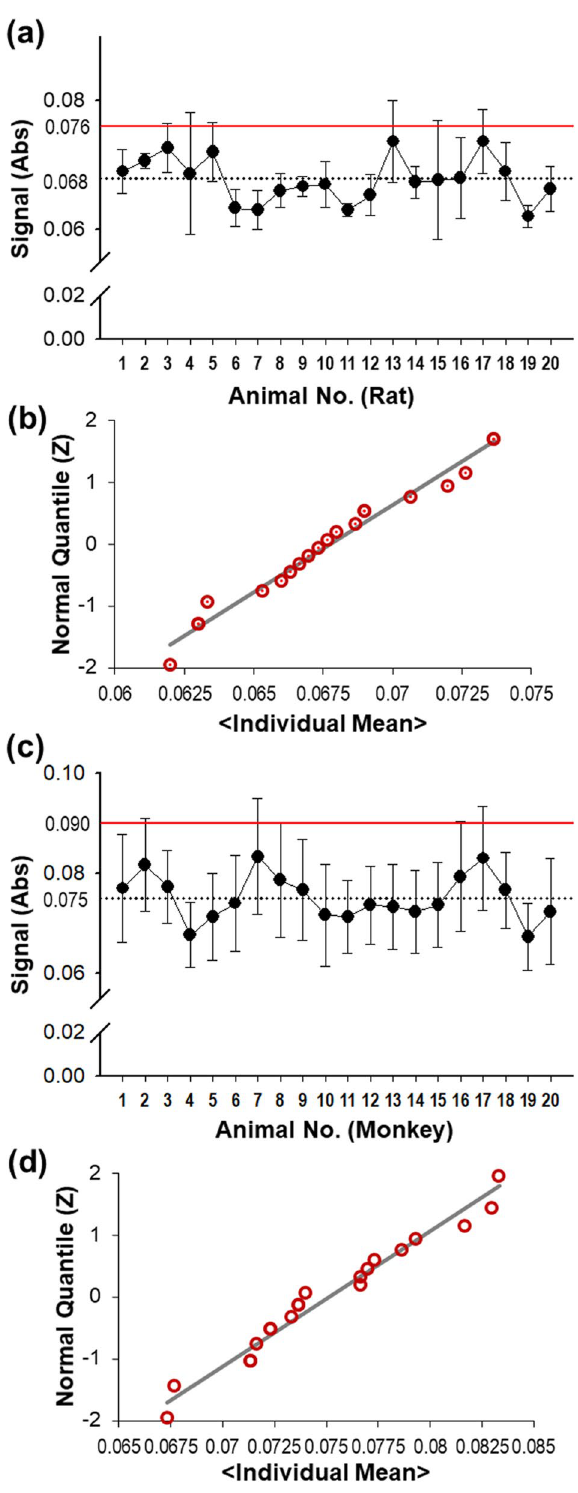
Figure 1. Negative cut-off (NCO) values were determined using 20 blank serum samples from rats and monkeys. For blank rat sera, ( a ) determination of the NCO value, ( b ) normal Q-Q plot of individual data. For blank monkey sera, ( c ) determination of the NCO value, ( d ) normal Q-Q plot of individual